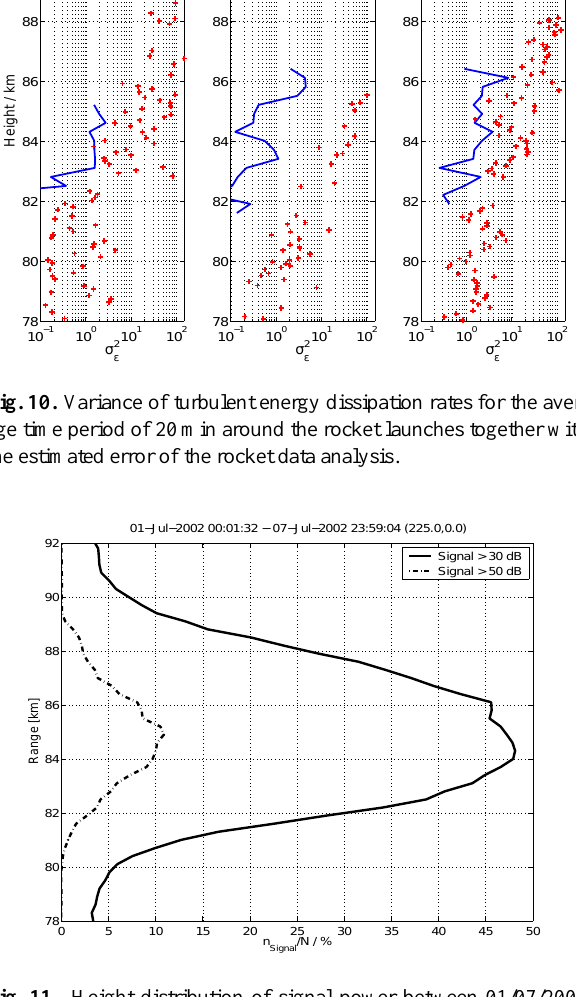
Fig. 9. Turbulent energy dissipation rates observed by different methods. The ALWIN VHF radar measurements are plotted to- gether with the data obtained by the CONE sensor of the sounding rockets (Rapp et al., 2004) as well as the climatological mean of energy dissipation rates from rocket measurements (L¨ubken et al., 2002).